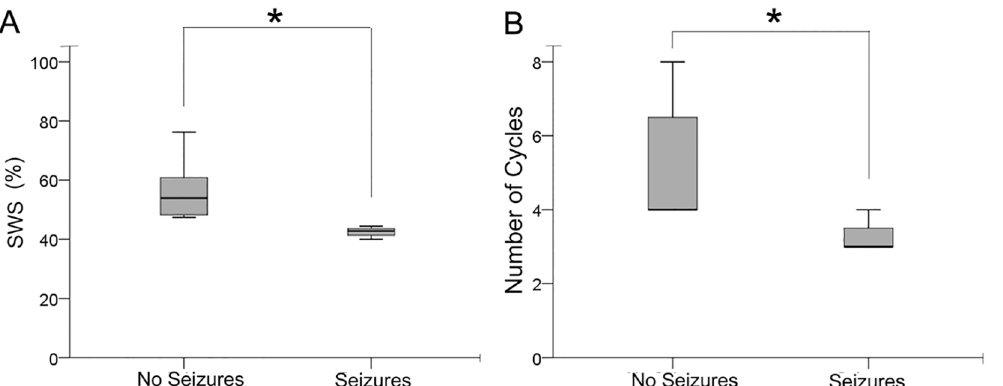
Fig 5. Seizures correlates with high delta power. Clinical severity of patients with RTT were recorded and documented. Seizures are a characteristic of RTT. Patients with RTT were separated into two groups: patients who showed no seizures and patients who experienced seizures (A) Patients with RTT who experienced seizures correlated negatively with lower SWS percent. (B) In addition patients with RTT who experienced seizures correlated negatively with lower cycles during sleep.